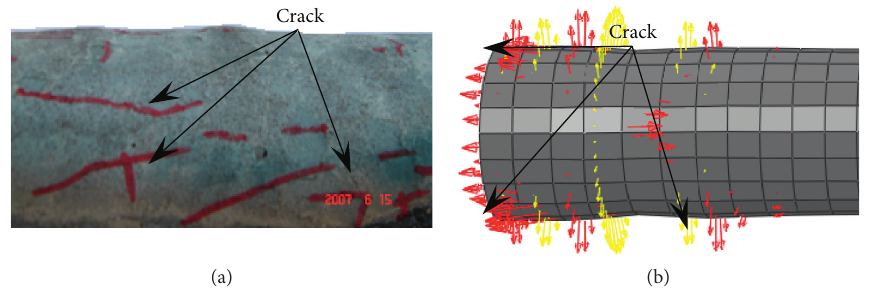
Figure 16: Failure modes of concrete with middle section. (a) Test result. (b) FE